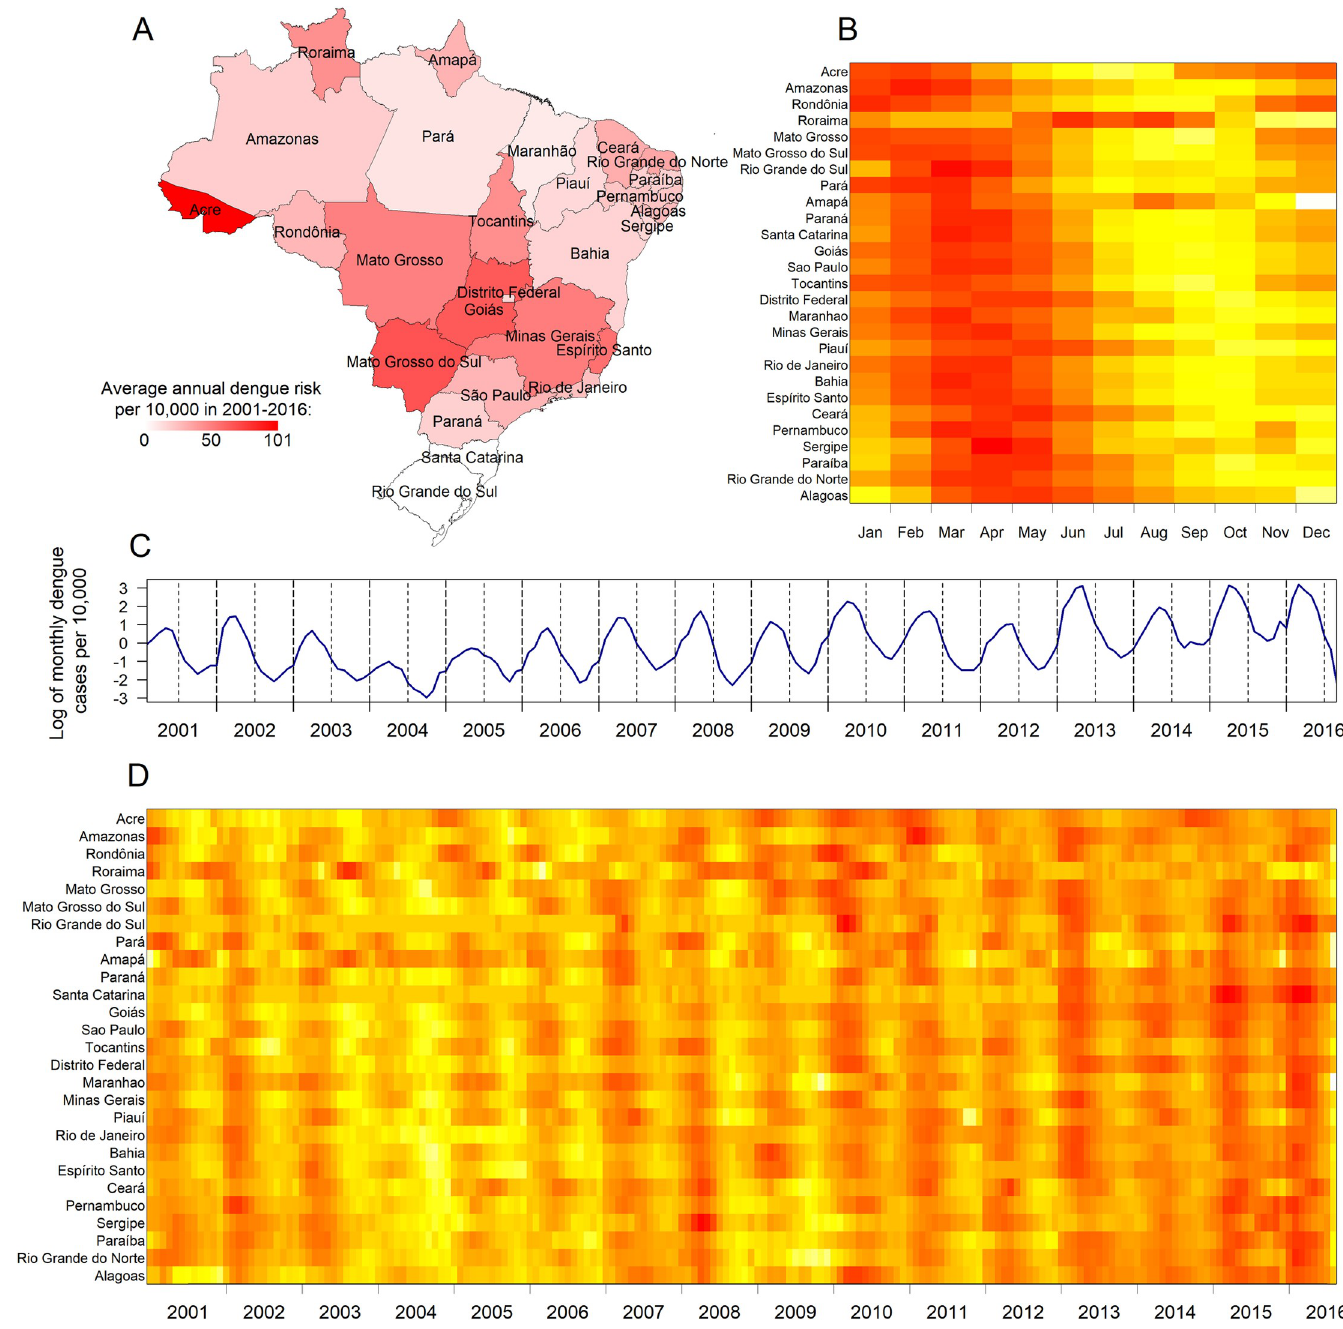
Fig 1. Summary of the spatio-temporal dynamics of dengue in Brazil. (A) Average annual dengue risk per 10,000 inhabitants in 2001–2016 for each state. Administrative boundaries were obtained from GADM (https://gadm.org). (B) Heat map of log-normalised average number of monthly cases in 2001–2016 for Brazilian states sorted by longitude: west (top) to east (bottom). (C) Log of monthly dengue cases per 10,000 inhabitants in Brazil. (D) Heat map of log-normalised case series for Brazilian states sorted by longitude: west (top) to east (bottom). Colours were scaled for each state independently so that yellow indicates the lowest number of dengue cases and red indicates the